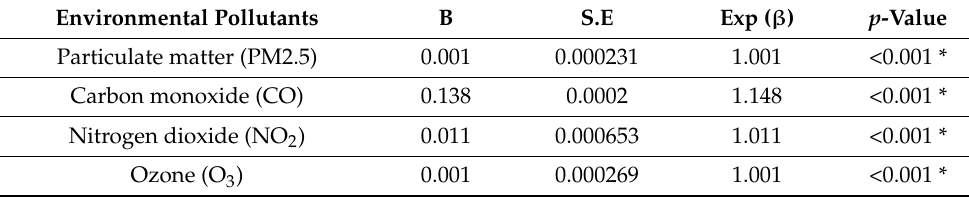
Table 3. Poisson Regression—PM2.5, CO, NO 2 and O 3 with the number of cases due to SARS-CoV-2. Environmental Pollutants B S.E Exp ( β ) p -Value Particulate matter (PM2.5) 0.001